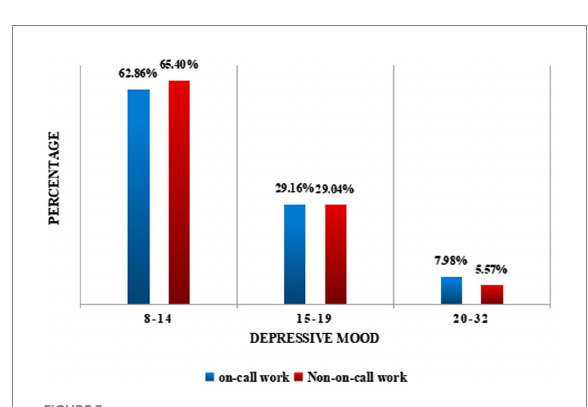
FIGURE 3 Comparison of depression scores between on-call and non-on- call rural migrant